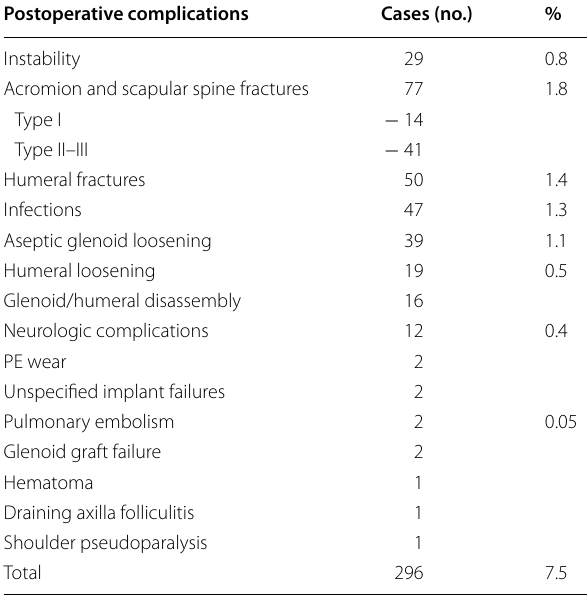
Table 4 Postoperative